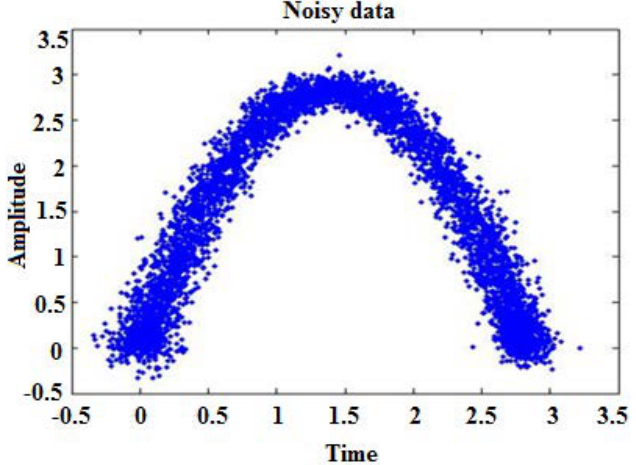
Figure 3. Logistic chaotic noise.